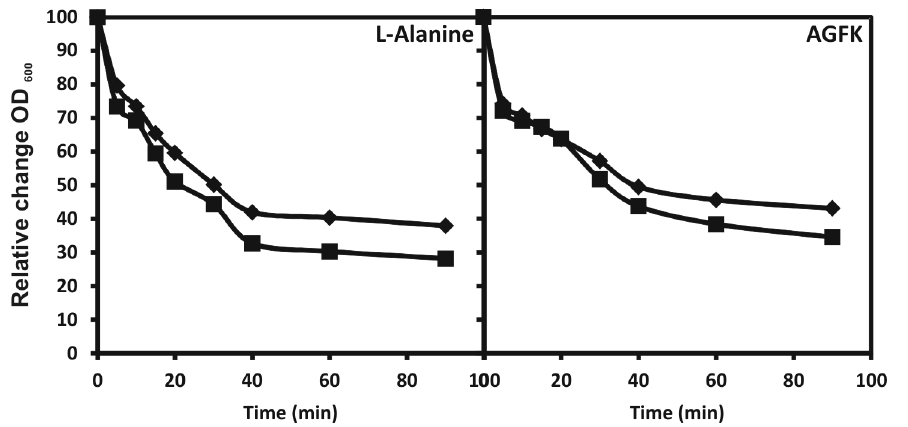
Figure 2. Germination of spore suspensions in l-alanine and AGFK solutions. Spores prepared from cells of 168 (diamonds) and BKH108 (squares) grown in DS medium were heat activated and subsequently incubated in 10 mM Tris-HCl (pH 7.5) with 10 mM l-alanine or with 3.3 mM l- asparaginate, 5.6 mM d-glucose, 5.6 mM d-fructose, and 10 mM KCl (AGFK). Germination was followed by measuring the A 600 of the spore suspension.